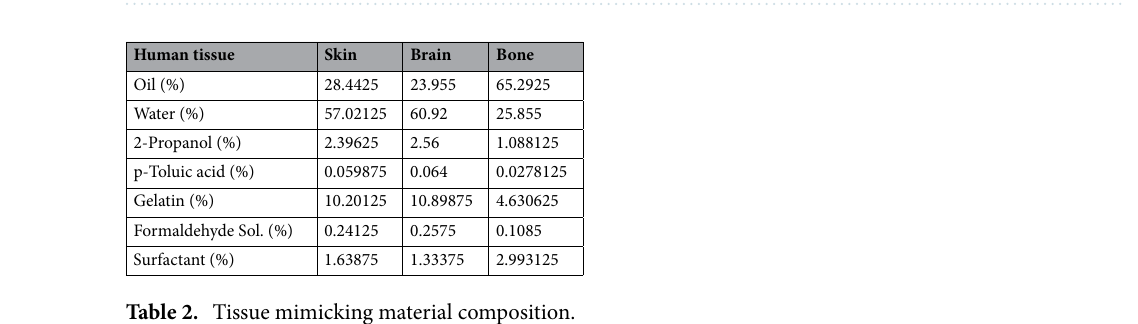
Figure 11. Reflection coefficient of the dielectric loaded rectangular waveguide for different thicknesses of ( a ) Skin, ( b ) Bone, and ( c ) Brain.